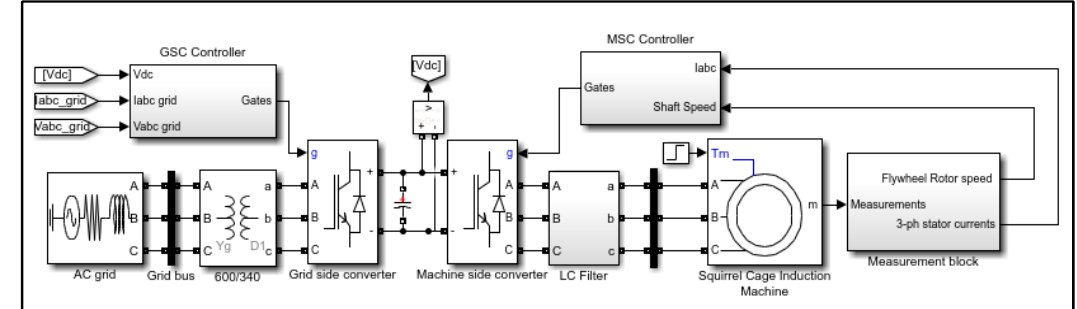
Figure 5. MATLAB/Simulink model of SCIM-FESS. Figure 5. MATLAB / Simulink model of SCIM-FESS.